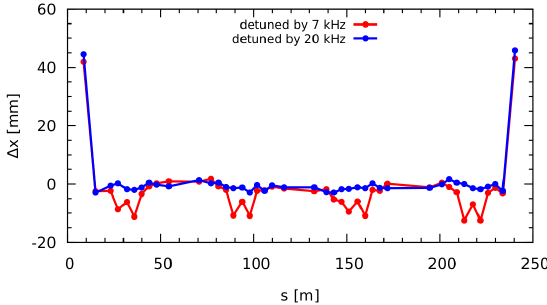
FIG. 11. Horizontal closed orbit distortions measured in the accumulator ring when the beam is injected with the frequency of the disabled SCL cavities shifted by 7 kHz (red) and 20 kHz (blue).